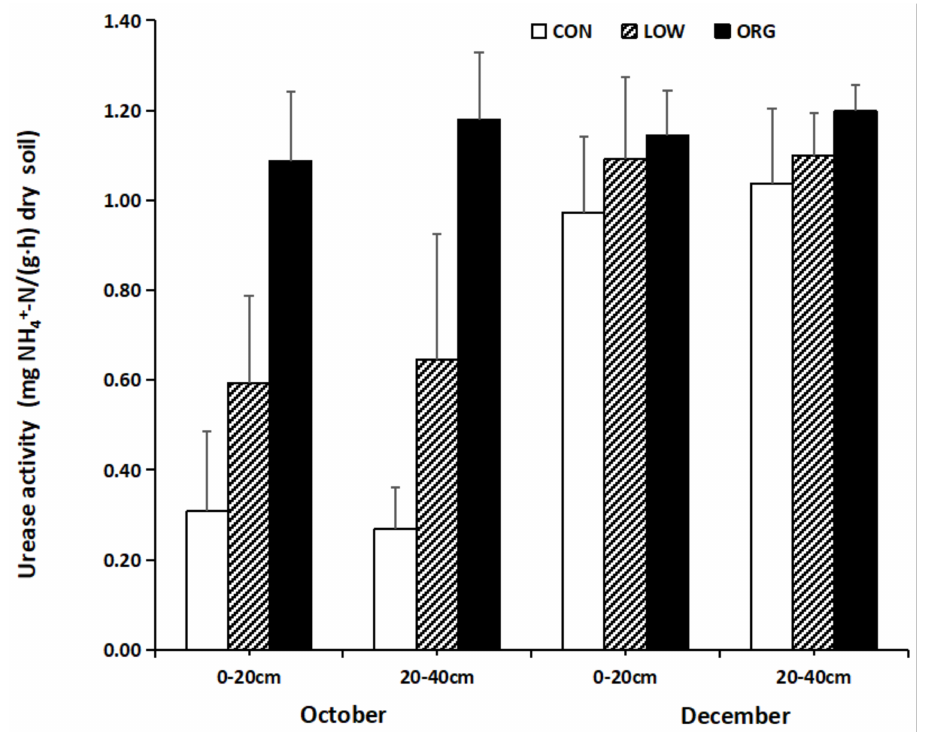
Figure 4. Effect of conventional, low-input, and organic practices on soil urease